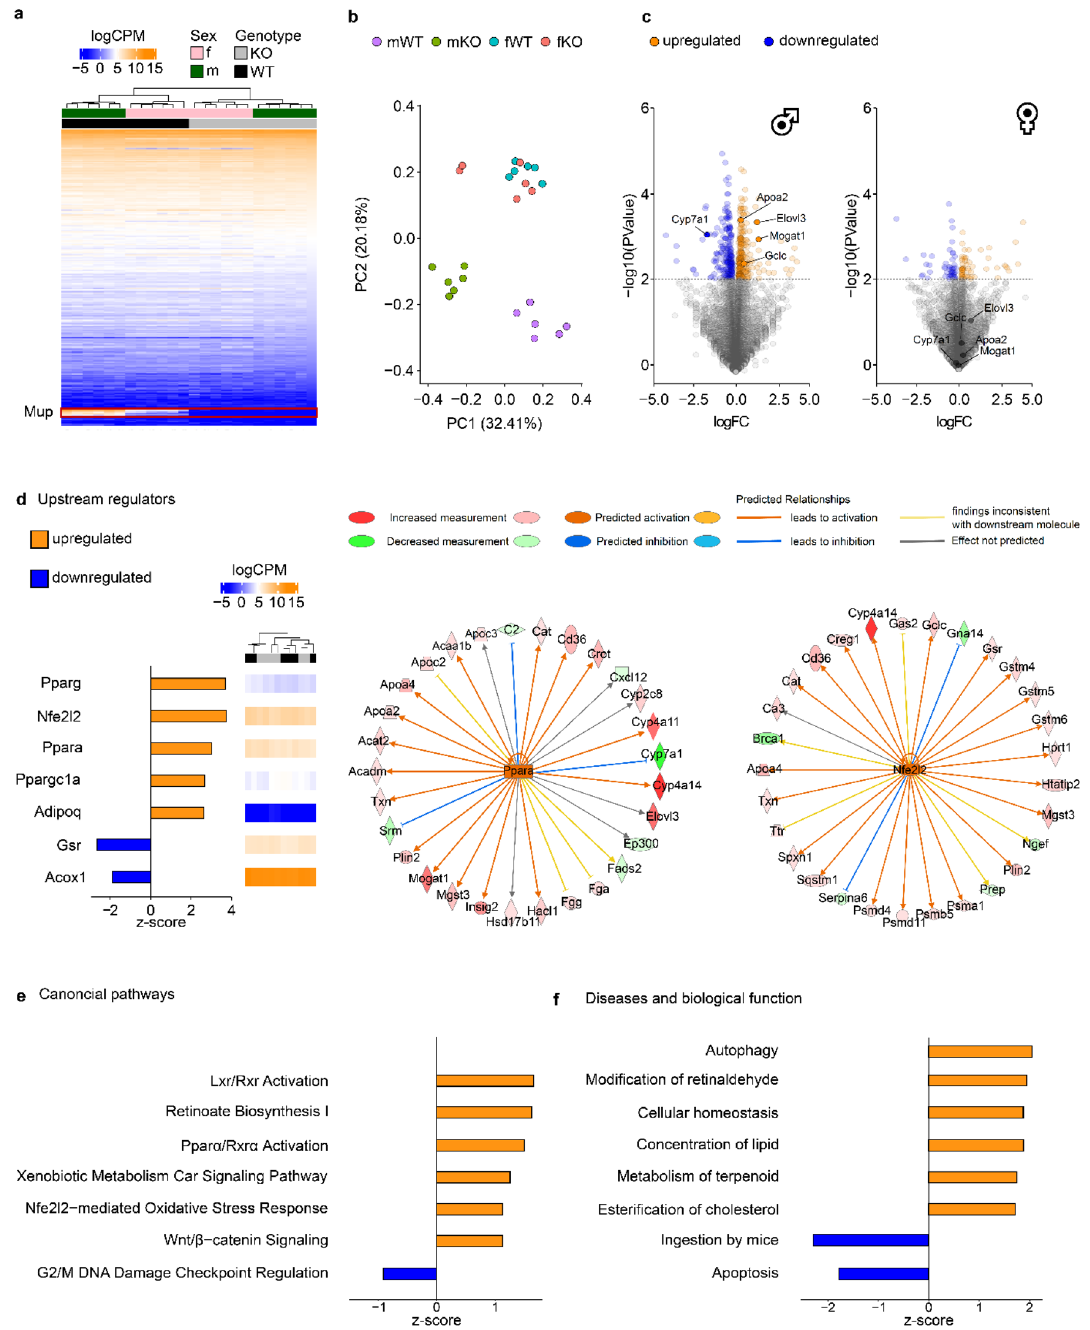
Figure 4. Hepatic gene expression in Mup knockout (KO) mice. ( a ) Heatmap indicating the gene expression in log 2 counts per million (logCPM) of differentially expressed genes (DEG; n = 571; p < 0.01) in male (m) and female (f) KO mice compared to respective wildtype (WT) mice. Color gradient corresponds to sample-individual gene expression level (blue: low gene expression, orange: high gene expression). The Mup gene family is highlighted (red box). ( b ) PCA plot based on identified DEG among experimental groups (mWT: purple, mKO: green, fWT: blue, fKO: red). ( c ) Volcano plot of differential gene expression analysis in male and female mice. Dotted line represents cut-off for DEG identification. Key lipogenic regulated genes in mKO mice are highlighted. ( d ) Selected upstream regulators involved in lipid metabolism and oxidative stress predicted by Ingenuity Pathway analysis (IPA) based on the mKO DEG data set. Gene expression (logCPM) of upstream regulators among experimental groups is indicated in the heatmap. The IPA upstream regulator prediction of peroxisome proliferator-activated receptor alpha (Pparα) and nuclear factor, erythroid-derived 2-like 2 (Nfe2l2) including predicted relationships with identified DEG among mKO vs. mWT mice is indicated in the circle plots. Color gradient of DEG represents differential gene expression level (red: upregulated, green: downregulated). Arrows correspond to predicted IPA consensus (orange: activation, blue: inhibition, yellow: inconsistent, grey: unpredicted). ( e , f ) The most affected ( e ) canonical pathways and ( f ) diseases and biological function networks of identified DEG in mKO vs. mWT comparisons as predicted by IPA. The bar plots ( d – f ) are based on the activation z-score, consistent with the particular activation state (activated: orange, inhibited: blue). In ( c – f ), the Mup gene family was excluded from the DEG data set for data representation and analysis. ( a–f ) all n =